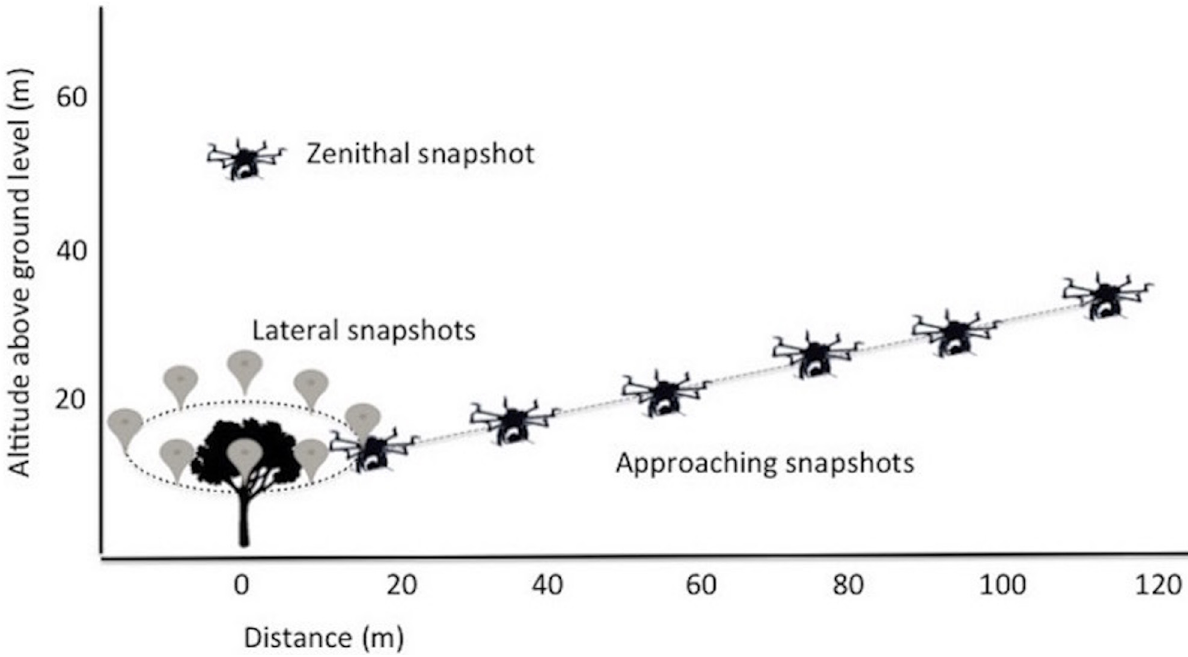
Fig 1. Illustration of the flight plan used during the experiments. The hexacopter first ascended to 50 m above ground level and took one zenithal image (zenithal snapshot), then flew at 15 m radius 360° around the tree and at 10 m AGL, taking regularly photos (lateral snapshots). Finally, the hexacopter approached the nest making a series of photos (approaching snapshots) at distances of 115, 95, 75, 55, 35, 15 m (30, 26, 22, 18, 14, 10 m AGL, respectively), simulating the aerial perspective of an approaching black kite that intends to inspect the